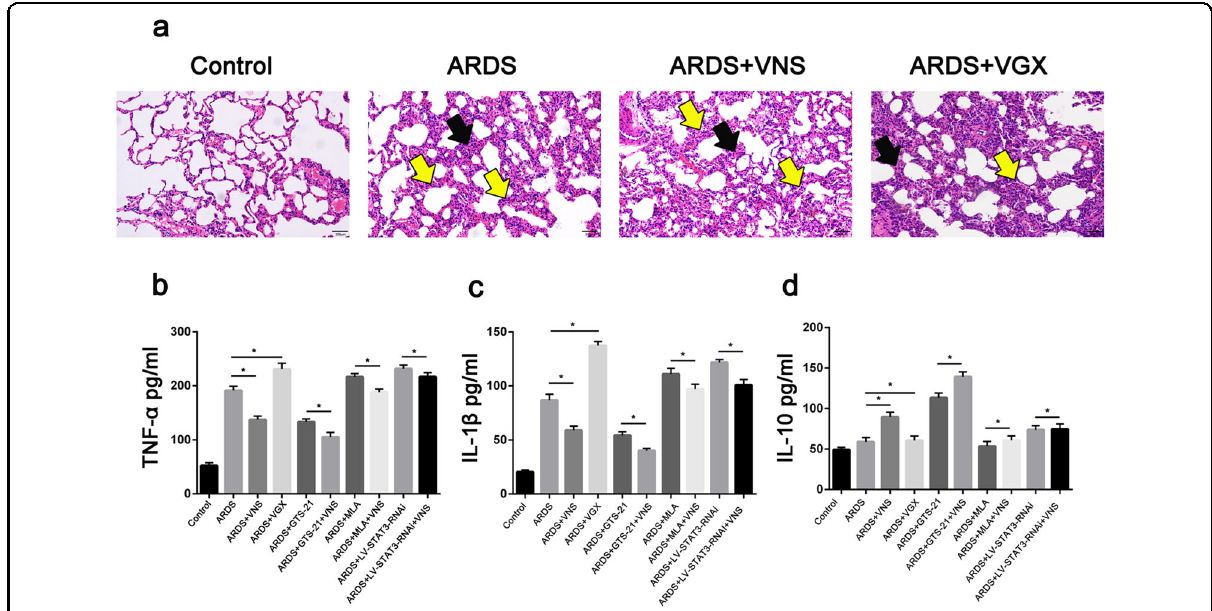
Fig. 1 Vagus nerve stimulation (VNS) alleviates in fl ammation in acute respiratory distress syndrome (ARDS). a Hematoxylin and eosin (H&E) staining analysis demonstrated that VNS signi fi cantly attenuated LPS-induced lung histopathological alterations (scale bar = 100 μ m), while vagotomized (VGX) rats showed increased lung histopathological changes upon LPS stimulation. In the ARDS groups, alveolar walls are moderately thickened (black arrow), alveolar cavities are narrow, and there is increased in fl ammatory cell in fi ltration (yellow arrow). In the VNS groups, alveolar walls were slightly thickened (black arrow) and alveolar cavities were narrowed, with a small amount of in fl ammatory cell in fi ltration (yellow arrow). In the VGX groups, alveolar walls were severely thickened (black arrow), alveolar cavities were narrow, and there was increased in fl ammatory cell in fi ltration (yellow arrow) ( n = 6 biological replicates). b – d Effect of acute respiratory distress syndrome (ARDS), vagus nerve stimulation (VNS), vagotomy (VGX), GTS-21, methyllycaconitine citrate (MLA), and LV-STAT3-RNAi treatments on TNF- α ( b ), IL-1 β ( c ), and IL-10 ( d ) levels in the bronchoalveolar lavage fl uid (BALF). The results are expressed as the mean ± SEM ( n = 6 biological replicates); * p < 0.05, ** p <